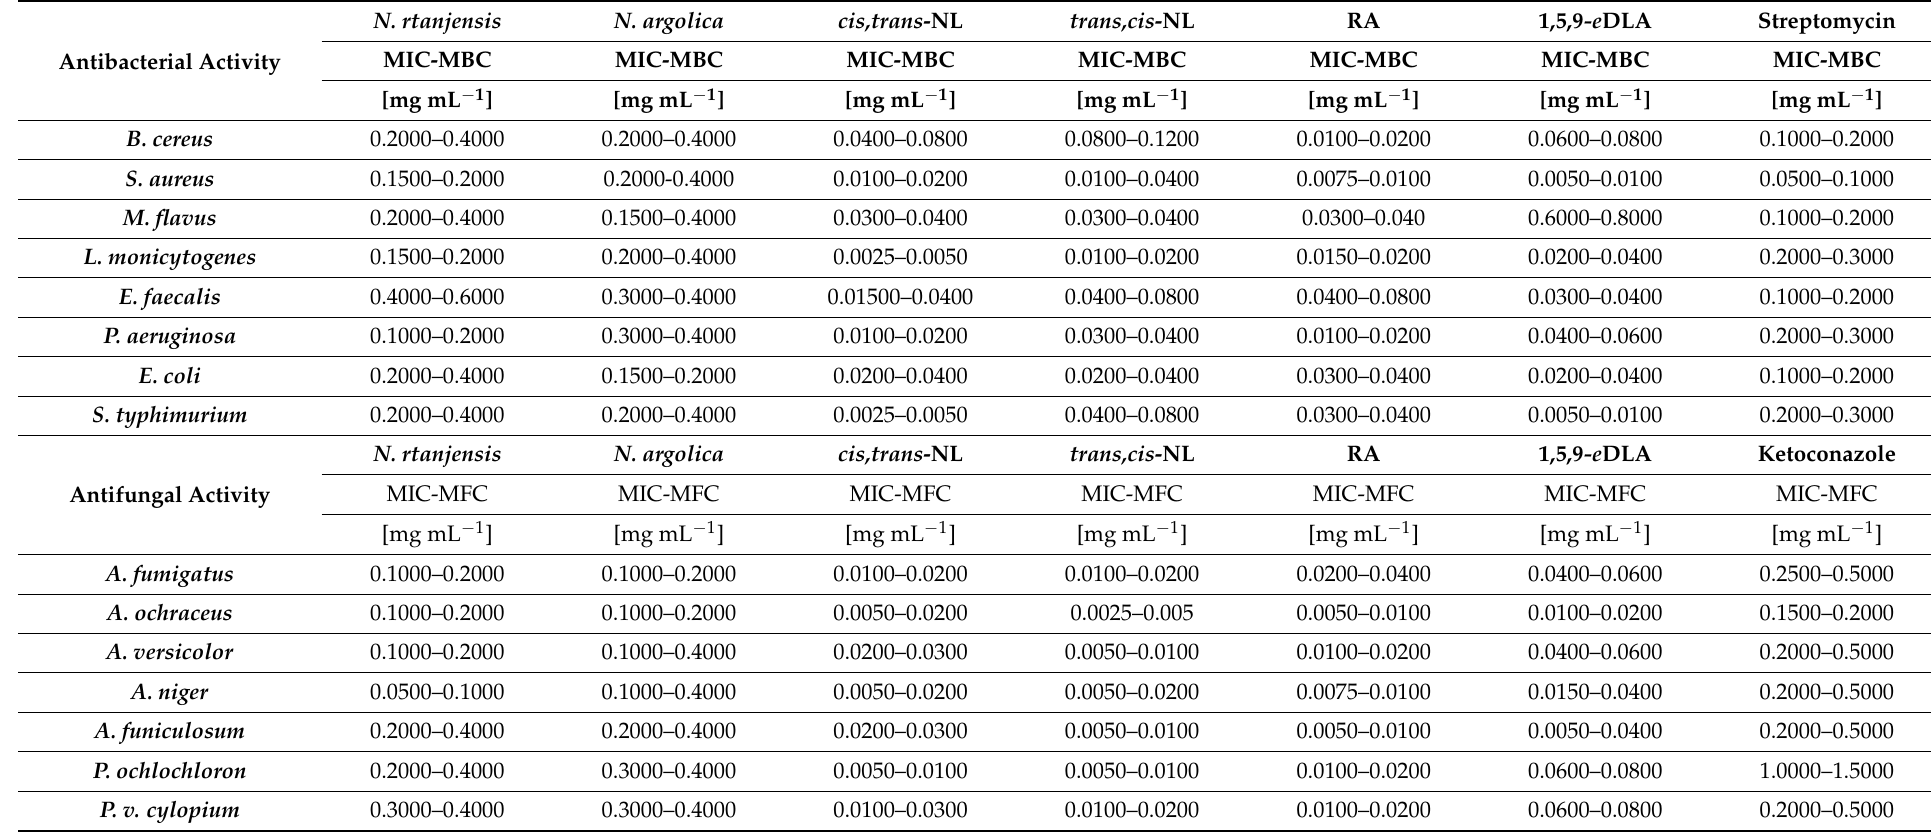
Table 2. Antimicrobial activities of N. rtanjensis , N. argolica subsp. argolica , and of cis,trans -nepetalactone ( cis,trans -NL), trans,cis -nepetalactone ( trans,cis -NL), 1,5,9-epideoxyloganic acid (1,5,9- e DLA) and rosmarinic acid (RA). Values for minimal inhibitory (MIC) and lethal concentration (MBC-bactericidal and MFC-fungicidal concentration) are presented as mg of extract/compound per mL (mg mL − 1